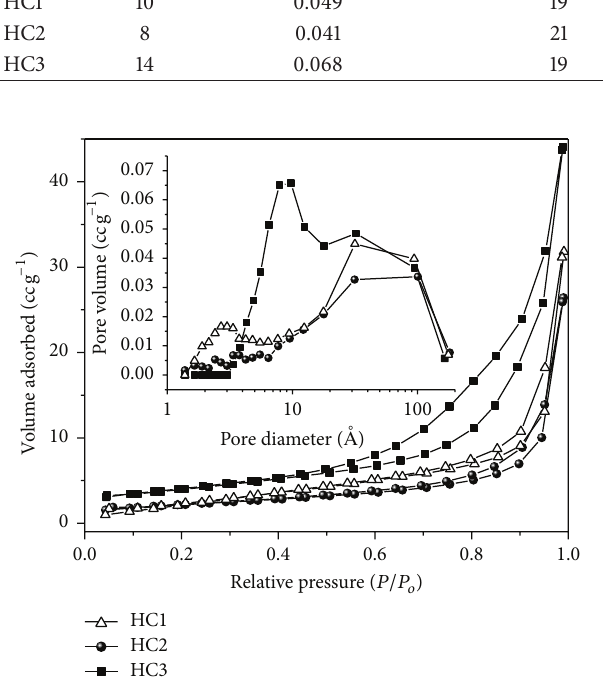
Figure 6: N 2 adsorption-desorption isotherms of calcined solids. Pore size distributions are shown in the insert.